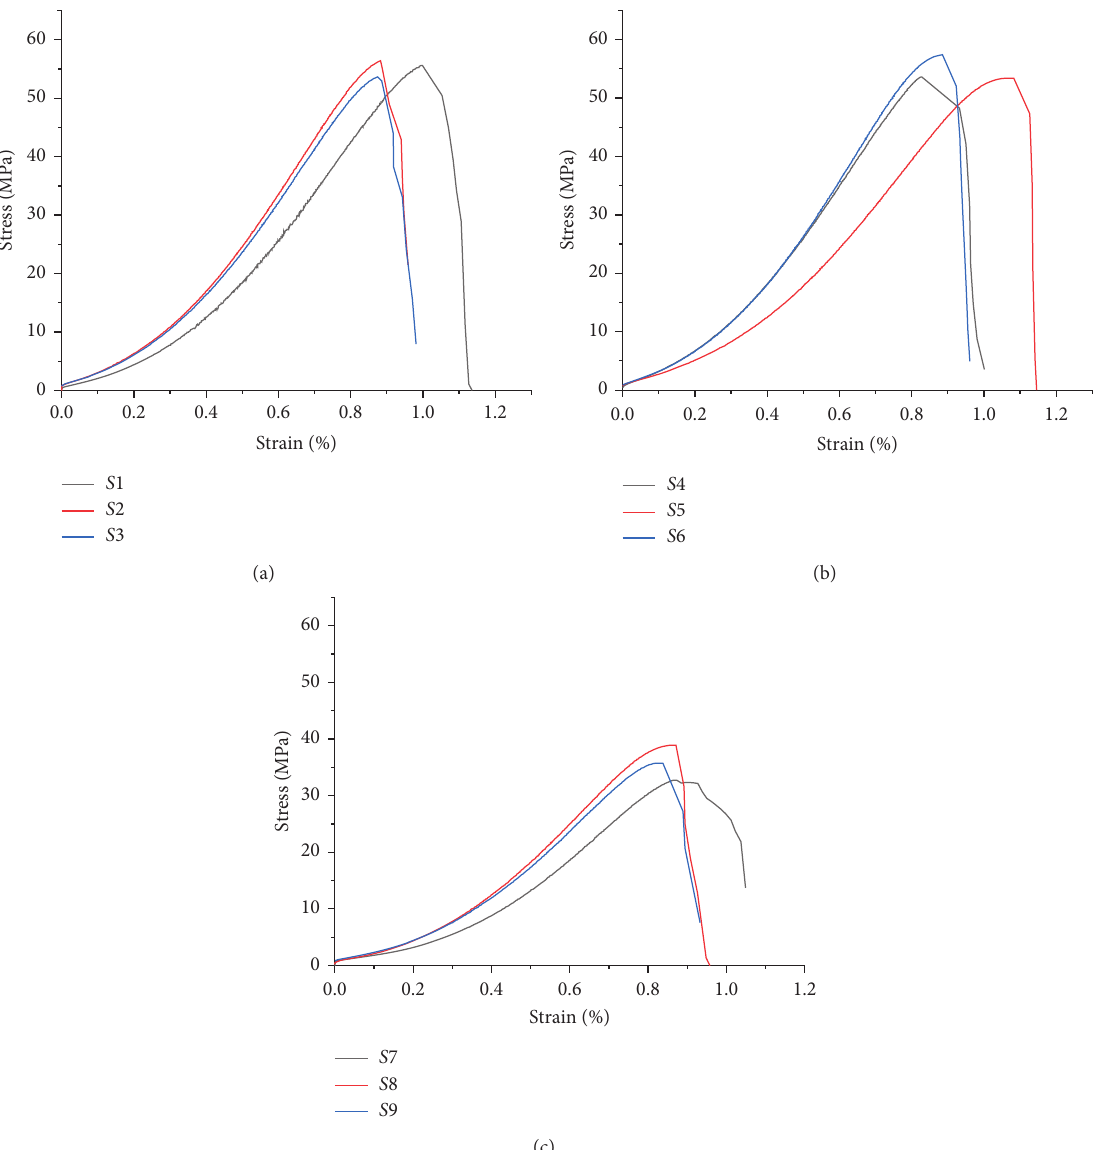
Figure 3: Stress-strain curves of rock samples on different moisture conditions under the uniaxial compression. (a) Dry state. (b) Natural state. (c) Water-saturated